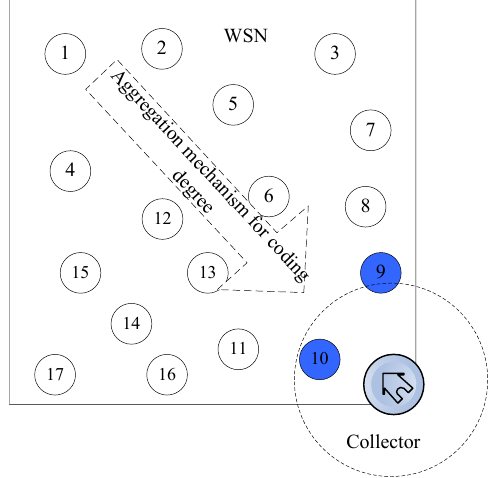
Figure 6. Aggregation mechanisms for coding degree in